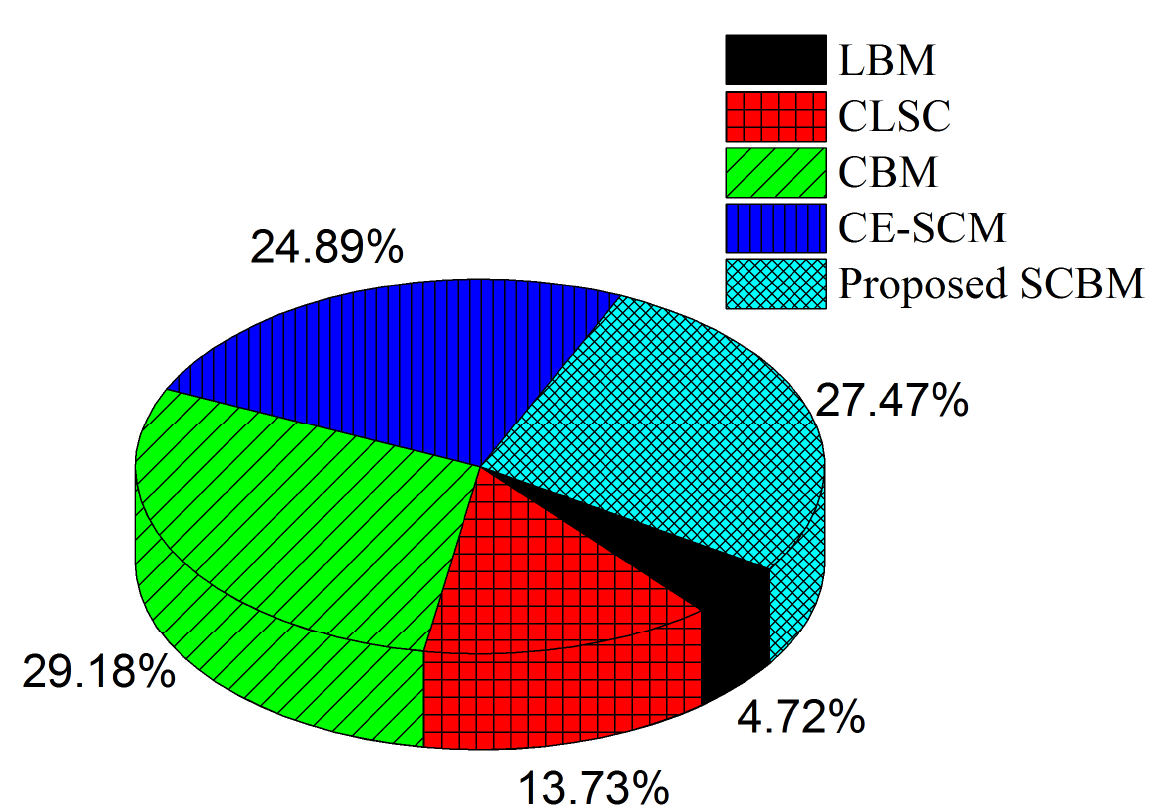
Figure 6. Degree of risked resources (in %) for various business models.